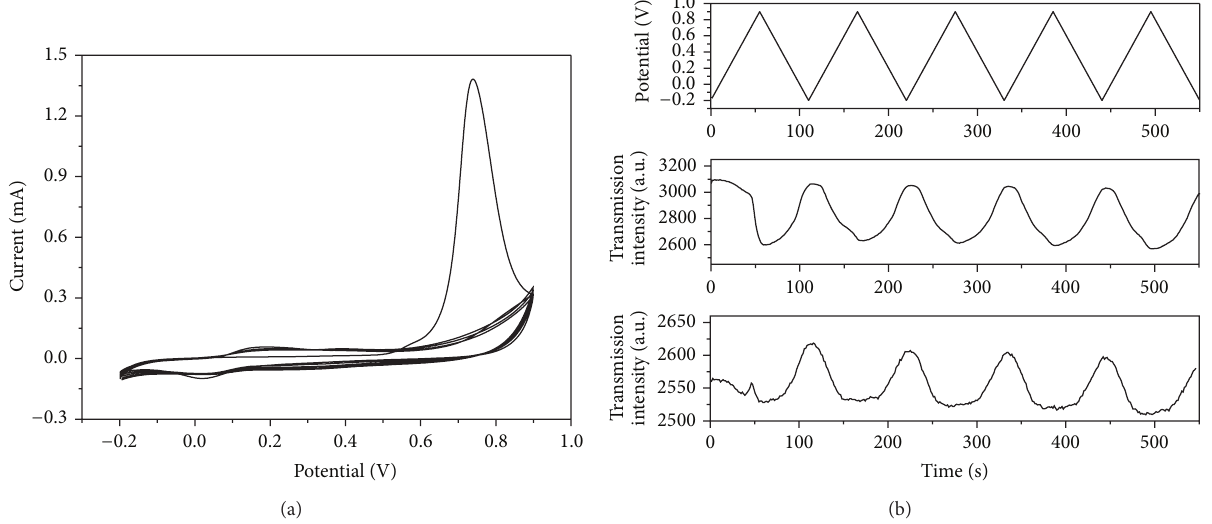
Figure 1: (a) CV trace and (b) corresponding potential ramp (top) with TSPR kinetic curves on BD-R (middle) and DVD-R (bottom) grating substrates during electropolymerization of 3-ABA in 0.5 MH 2 SO 4 at scan rate of 20 mV/s for 5